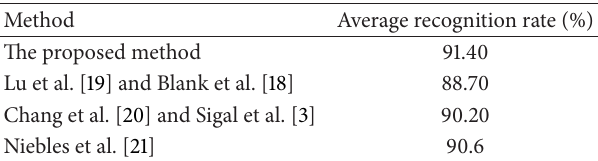
Figure 6: Confusion matrix for Weizmann data set. Table 3: Compared with other approaches on HumanEva